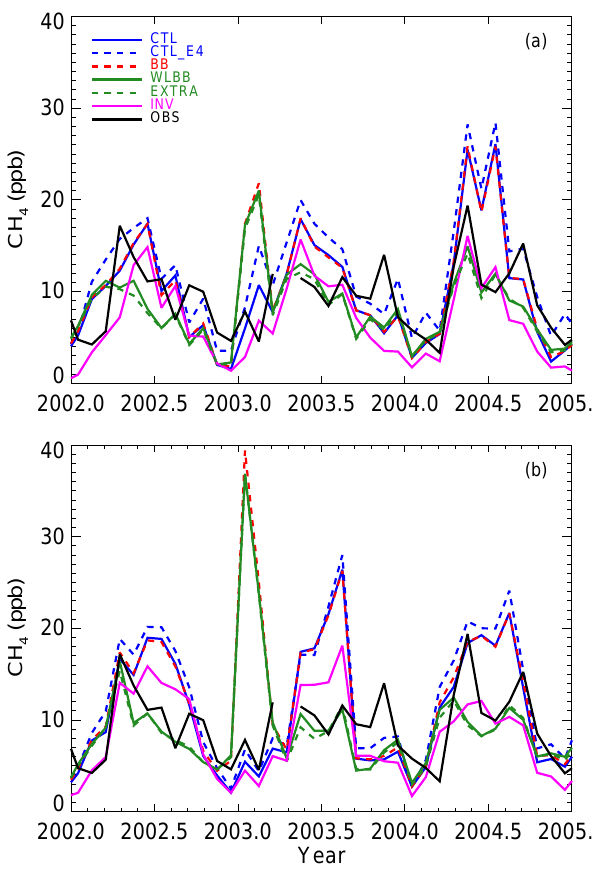
Figure 4. Monthly mean methane residuals for 2002–2004 at Cape Grim for the observations (black) and six emission scenarios (colours shown in key): (a) ACCESS (b) CCAM. Note that the ob- servational mean residual for April 2003 is missing, due to lack of radon data with which to define the baseline threshold (rather than a lack of methane